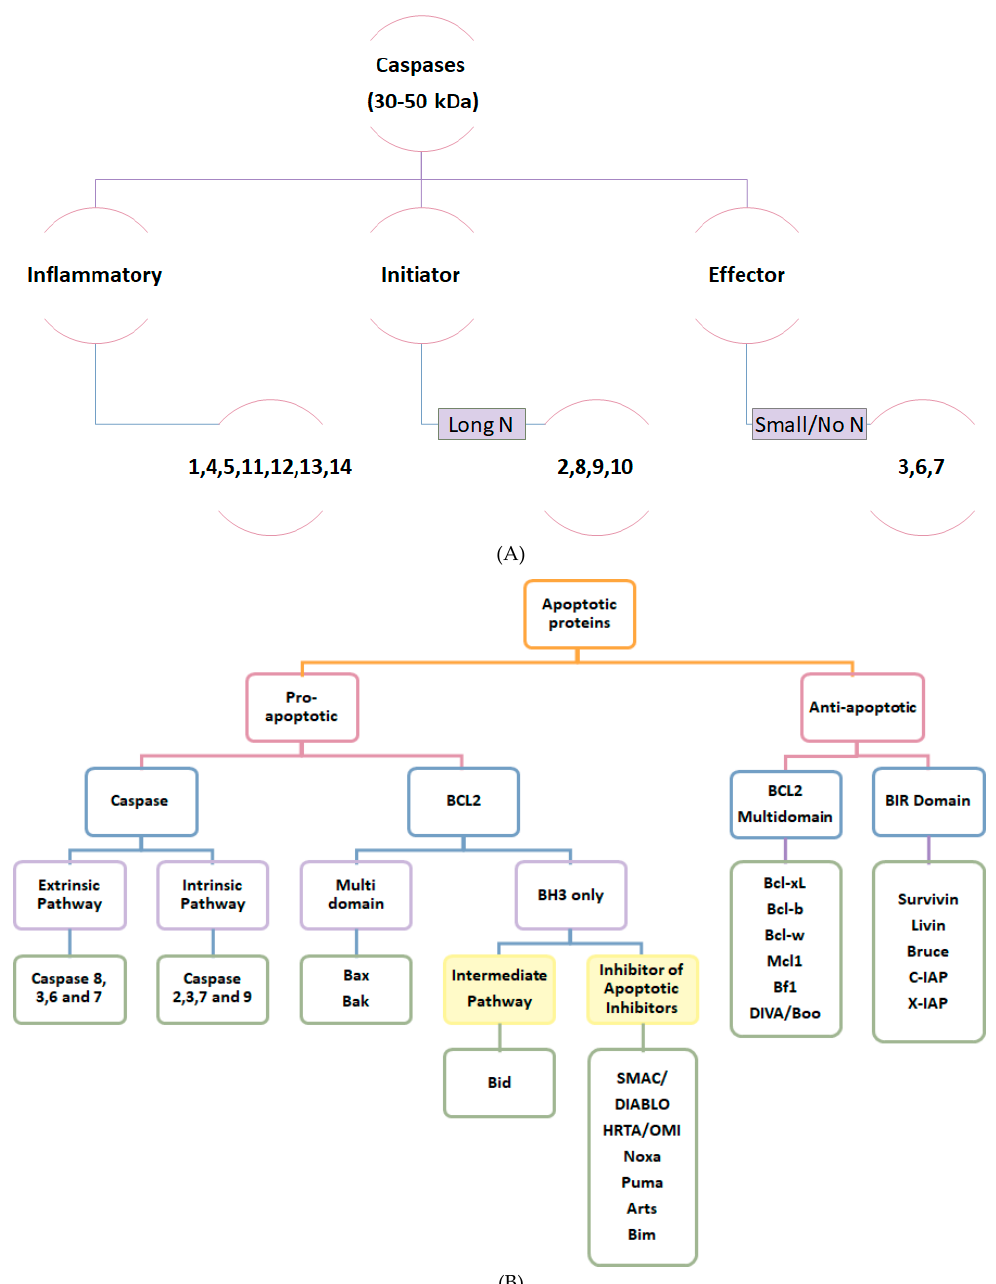
Figure 2. ( A ) Classification of caspases. Caspases are divided into three subtypes: inflammatory caspases (1,4,5,11,12,13,14), initiator caspases in intrinsic and extrinsic apoptotic pathways with long N terminal (2,8,9,10), and effector caspases known for their short/absent N-terminal (3,6,7) [6,8]. ( B ) Classification of apoptotic proteins according to their function in apoptosis. Pro-apoptotic proteins are classified into Caspases and BCL-2 families. Caspases are further subdivided according to their role in apoptotic pathway. Bcl-2 proteins are classified as multidomain proteins (Bax and Bak) and BH3 only domain that either serve in intermediate pathway (Bid and inhibitors of apoptotic inhibitors such as SMAC/Diablo, HRTA/Omi, Noxa, Puma, Arts and Bim). Anti-apoptotic proteins are classified as BCL-2 multi-domain proteins (Bcl-xl, Bcl-b, Bcl-w, Mcl-1, Bf1 and DIVA/Boo) and BIR domain family (survivin, livin, bruce, c-IAP and x-IAP).